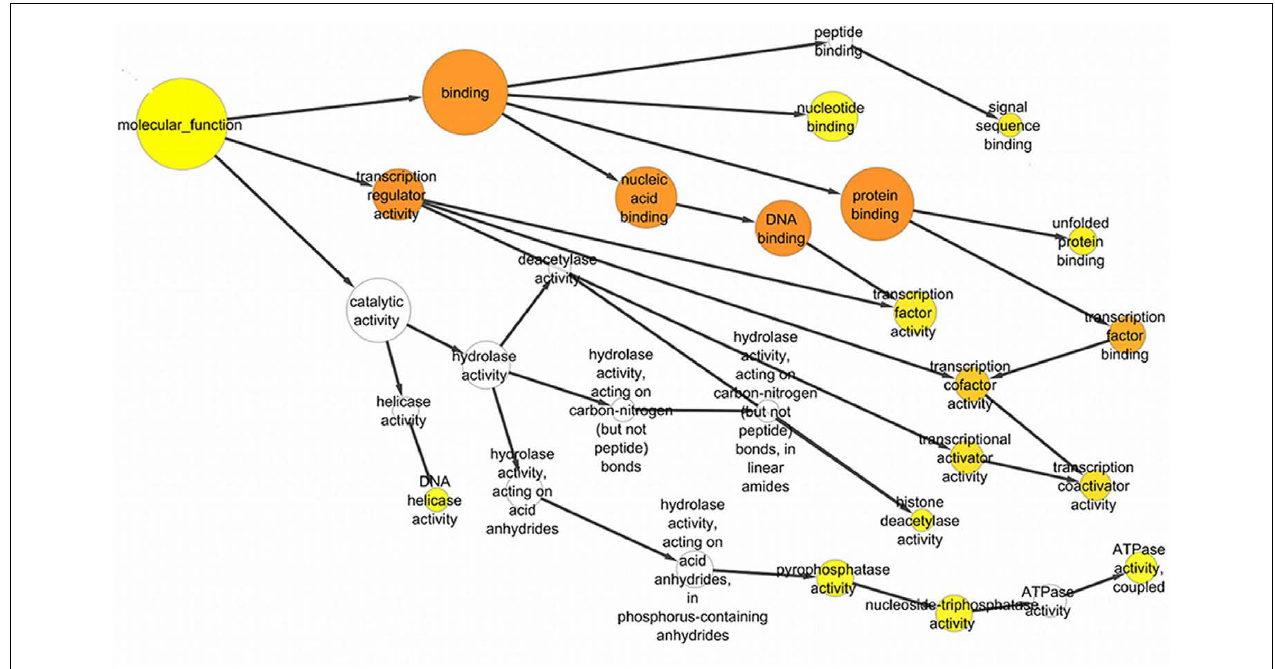
FIGURE 4 |The significant GO ontological data related to molecular function with the GO nodes are listed in circles connected by black arrows to the GO nodes. These yellow and orange color nodes correspond to the statistically significant nodes.